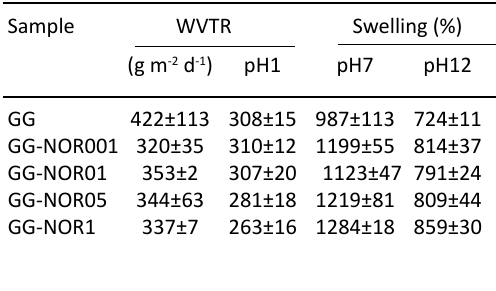
Table 1. The water vapour transmission rates (WVTR) and swelling properties of GG and GG-NOR films (mean±SD) (n=3)